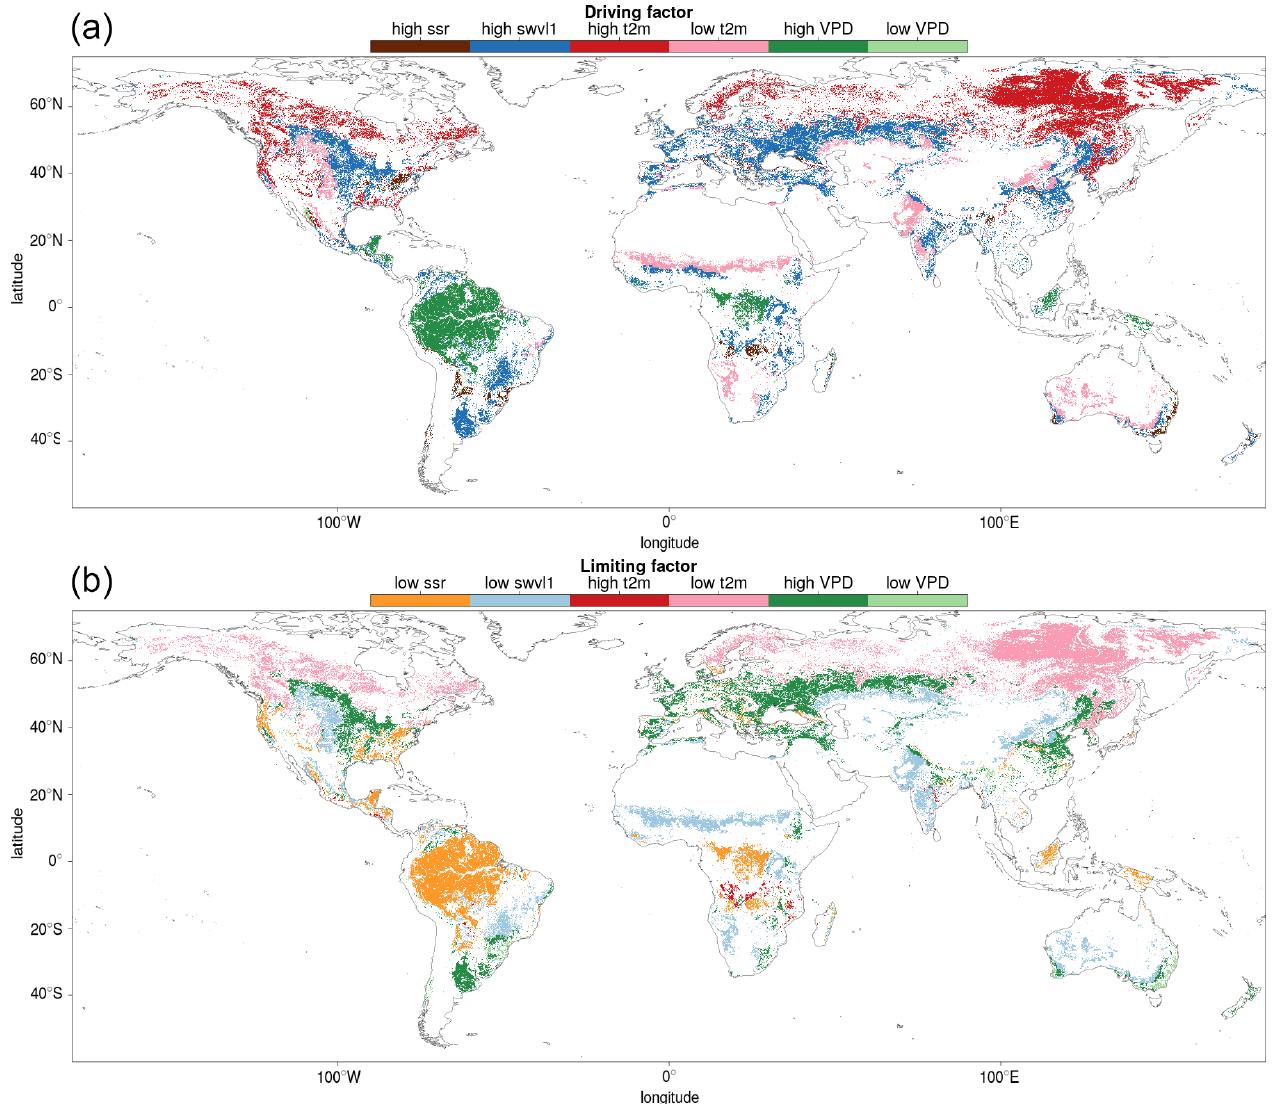
Figure 11. The driving (a) and limiting (b) meteorological conditions displayed at a globe scale. The driving and limiting variables are those that correspond to the largest upward and downward fluctuations respectively in downscaled SIF for each Köppen–Geiger climate–vegetation